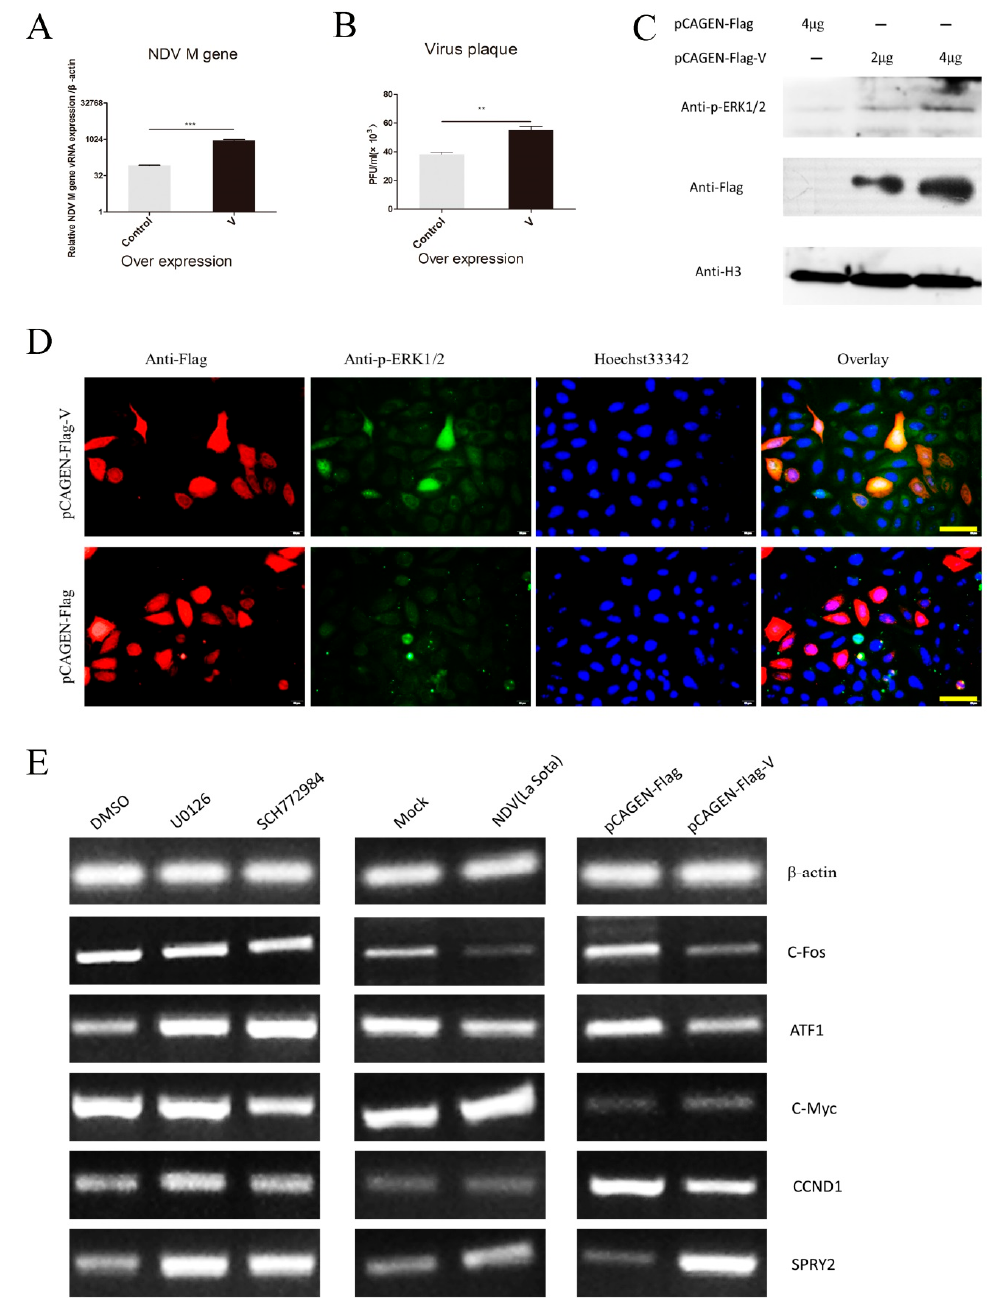
Figure 3. The V protein activates the extracellular signal-regulated kinase (ERK) pathway and benefits Newcastle disease virus (NDV) replication. ( A ) HeLa cells were transfected with pCAGEN-Flag (control) or pCAGEN-Flag-V (to overexpress the V protein). After 24 h, cells were infected with NDV (F48E9, 1 multiplicity of infection). After 24 h, the quantitative reverse transcription polymerase chain reaction (qRT-PCR) was used to measure viral RNA in cell lysates. Data are expressed as means ± SD of three independent experiments. ( B ) Viral plaque formation was assessed to measure the number of viral particles in supernatants. Data are expressed as means ± SD of three independent experiments. ** p < 0.01 and *** p < 0.001. ( C ) Cells were transfected with pCAGEN-Flag or pCAGEN-Flag-V. After 24 h, cells were harvested and analyzed by Western blotting with H3 histone used as a reference. ( D )